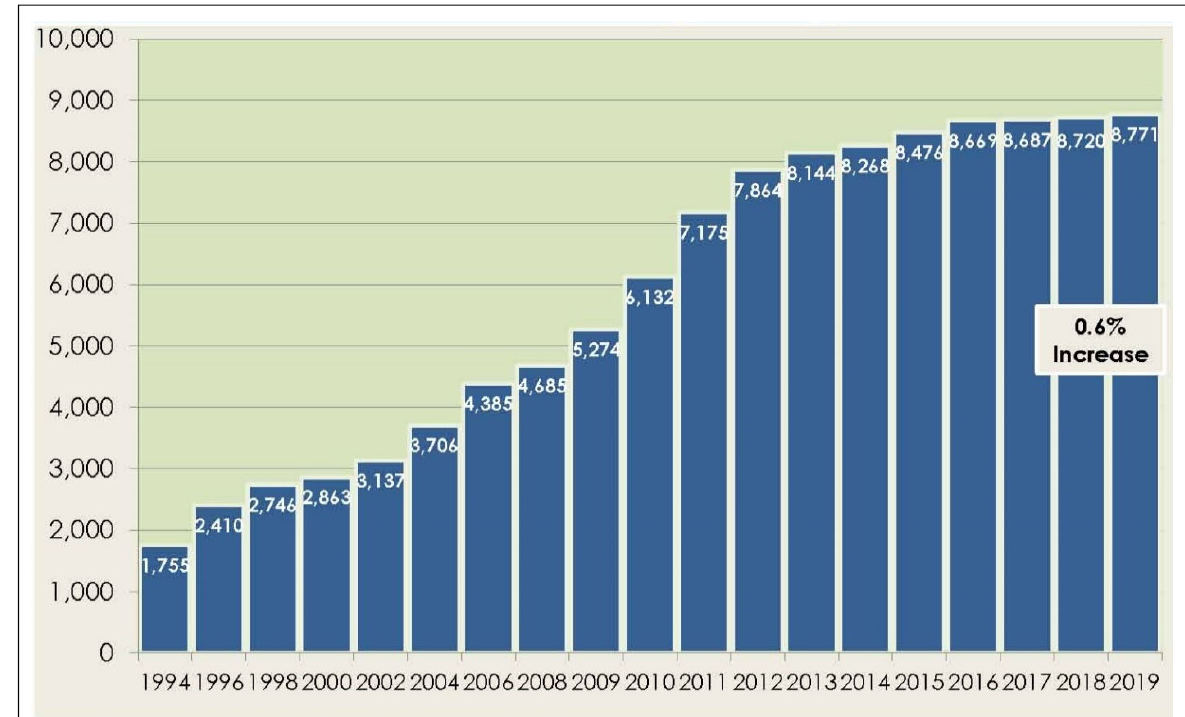
Figure 1. USDA National Count of National Farmers Market Directory Listings,